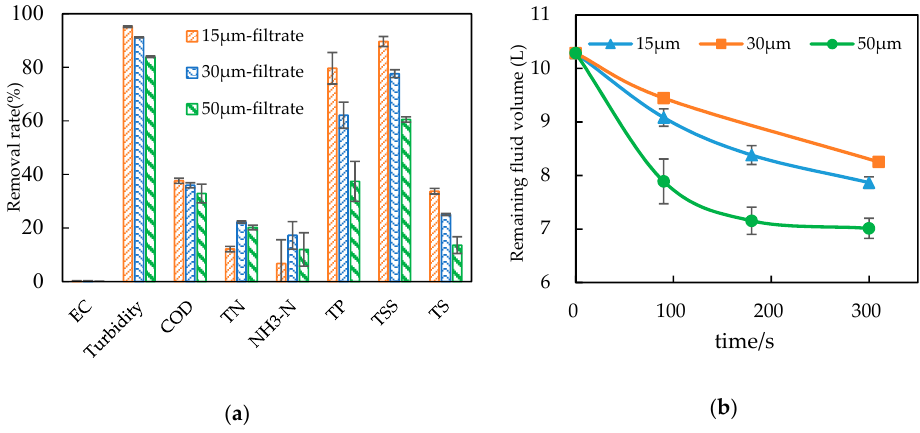
Figure 2. Water parameters removal rates ( a ) and variations in volume of separation liquids ( b ) by filter cloths with different precisions. Table 4. The significance of water parameter removal rates (%) in filtrates by filter cloth with different filtering precisions.